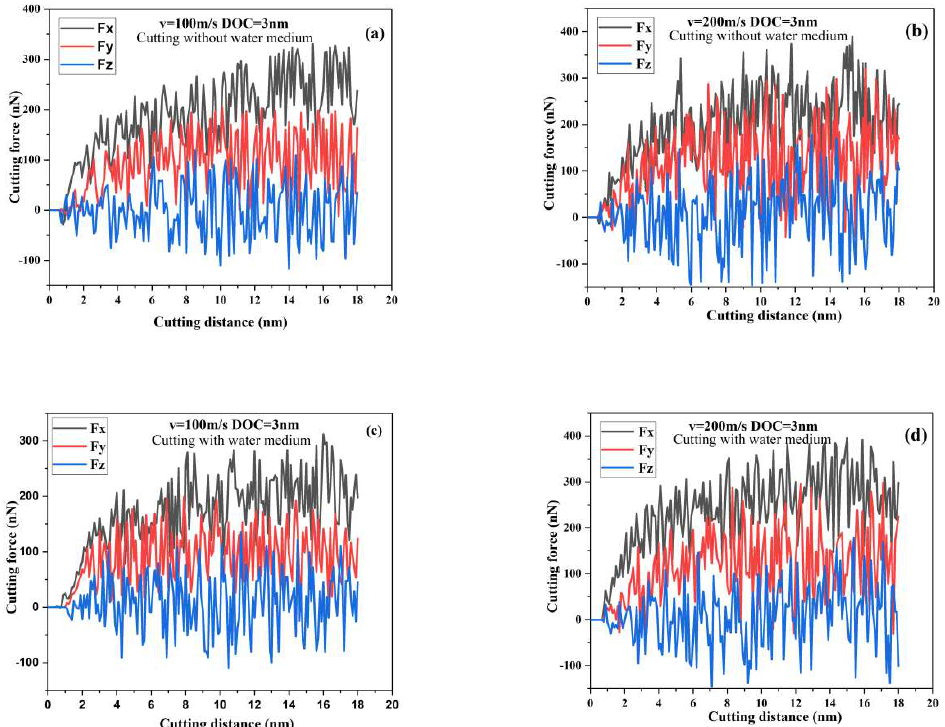
Figure 11. Cutting force at different cutting speeds (( a ) cutting speed is 100 m/s and without water medium ( b ) cutting depth is speed is 200 m/s and without water medium ( c ) cutting speed is 100 m/s and without water medium ( d ) cutting speed is 200 m/s and with water medium).